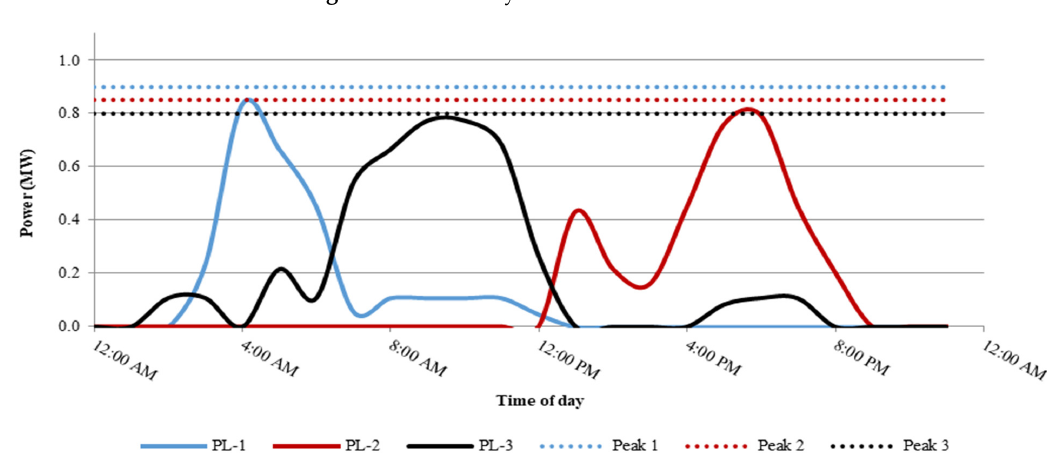
Figure 6. Availability of the MESS at each PL.